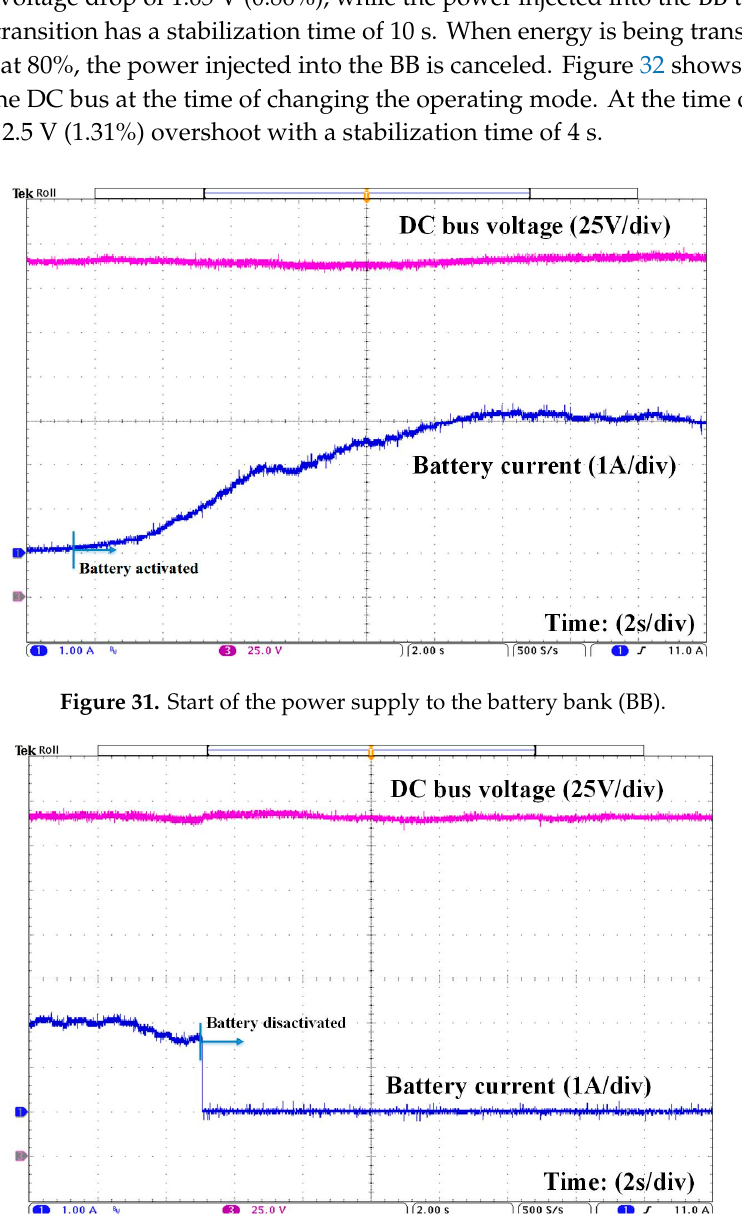
Figure 32. End of the power supply to the BB.